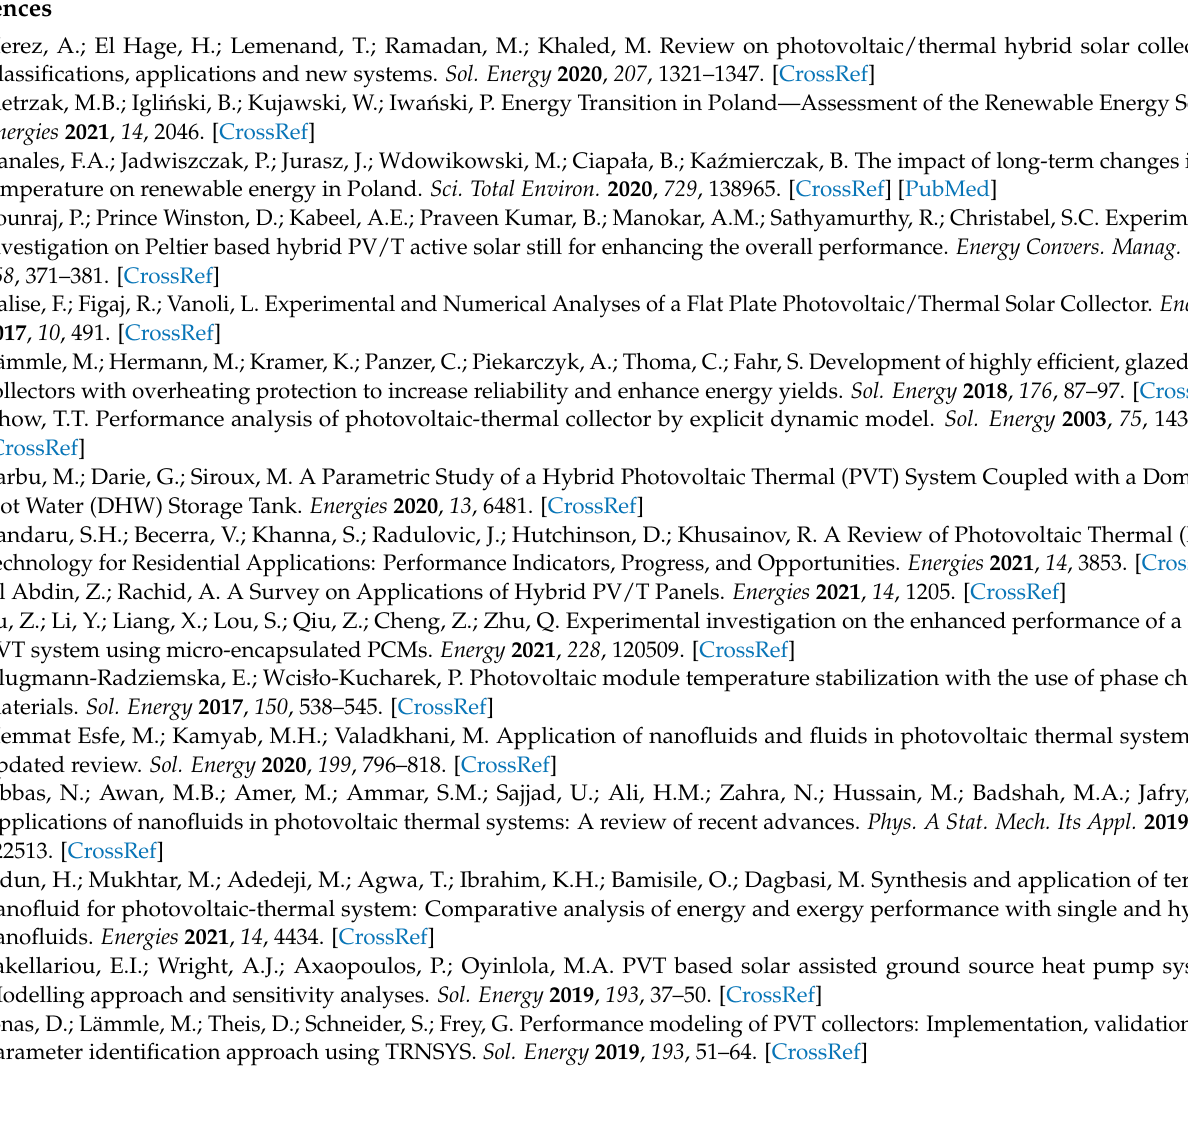
tank with an immersed coiled-tube heat